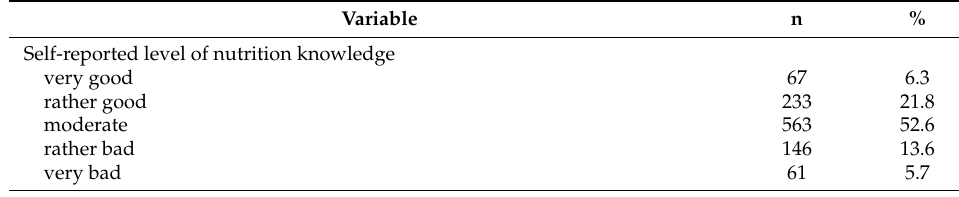
Table 2. Respondents’ knowledge regarding nutrition and dietary habits (n =